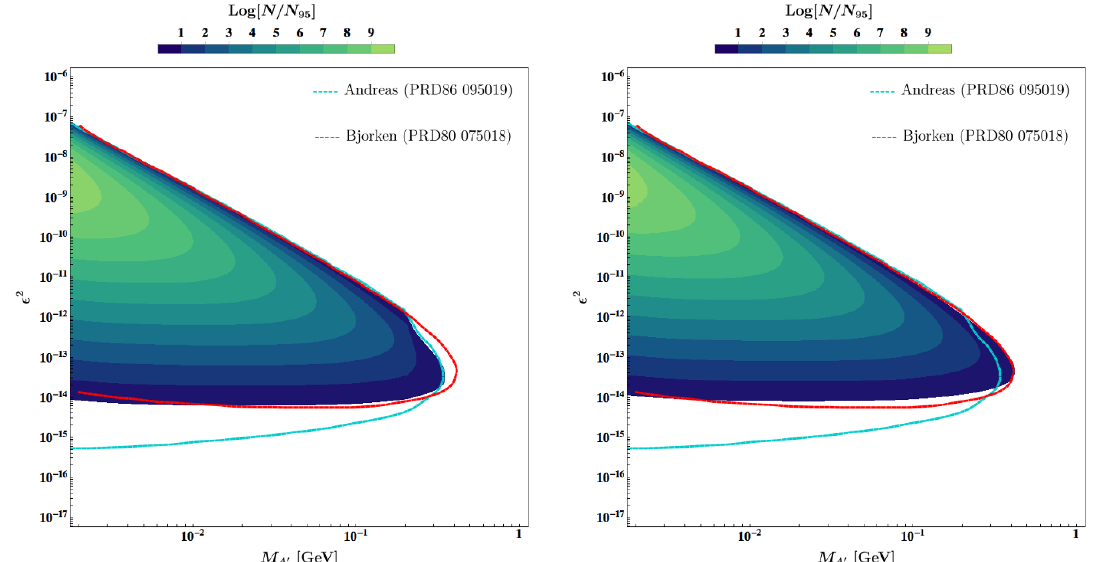
Figure 18 . Expected number of events N in this work for a secluded hidden photon A SLAC E137 experiment obtained from the Bjorken implementation as a function of the mixing parameter (cid:15) 2 and the mass M A 0 normalized to the 95% C.L. limit N 95 . The red (Bjorken) and cyan (Andreas) lines show the exclusion contours calculated in [27] and in [33], respectively. Left: including the full A 0 width, in particular also the partial width into muons. Right: only including the partial width of the A 0 into electrons, assuming N 95 = 10 and including the extra factor of